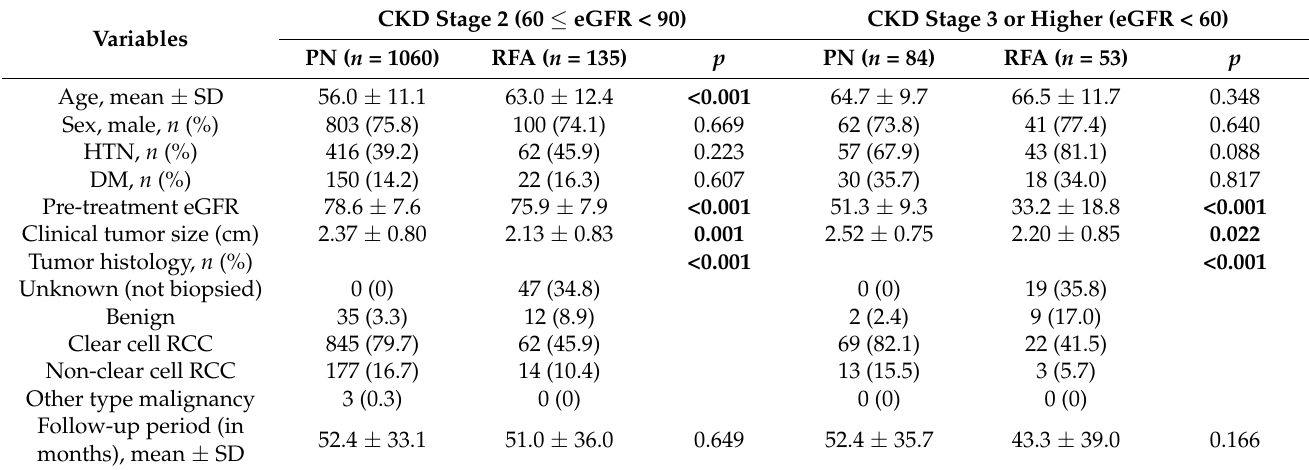
Table 1. Patients’ demographics and tumor